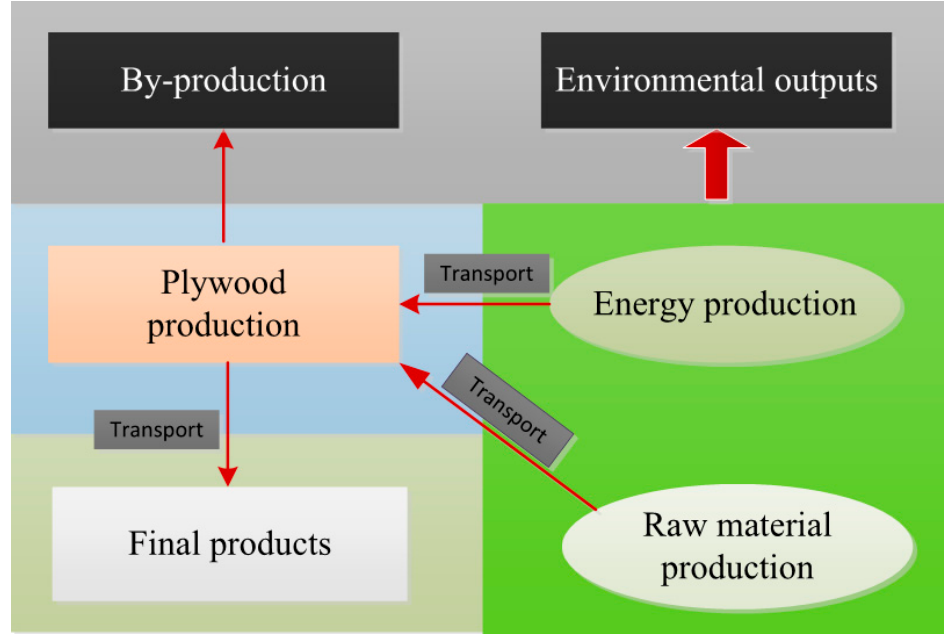
Figure 1. System boundary of plywood manufacturing process of life cycle assessment (LCA).